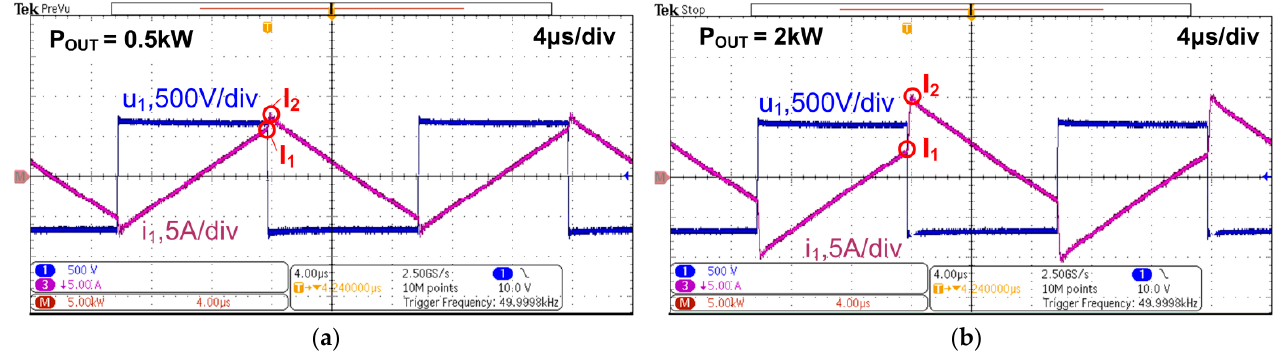
Figure 16. Experimental waveforms of the current i 1 and voltage u 1 measured for: ( a ) P OUT = 0.5 kW; ( b ) P OUT = 2 kW.